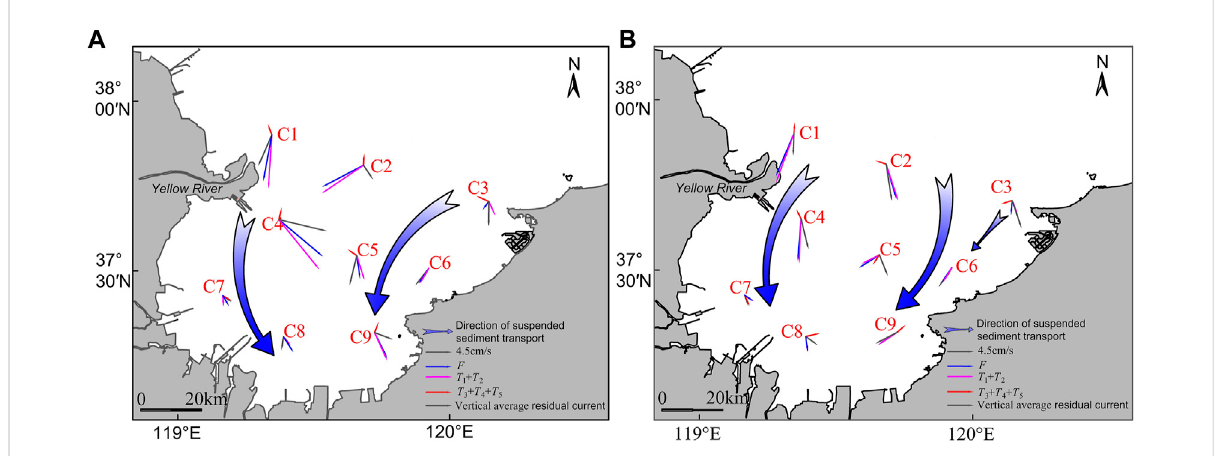
FIGURE 12 Vector diagrams of F (blue arrow), vertical average residual current, T 1 + T 2 (gray arrow) and T 3 + T 4 + T 5 (red arrow) during the spring (A) and moderate (B) tides ( F of the C6 – C8 stations increased to twice the original; T 3 + T 4 + T 5 of the C6 – C8 stations increased to 6 times the original; and T 3 + T 4 + T 5 of the C1 – C5 and C9 stations increased to 3 times of original). Gradient blue arrow represents the direction of suspended sediment